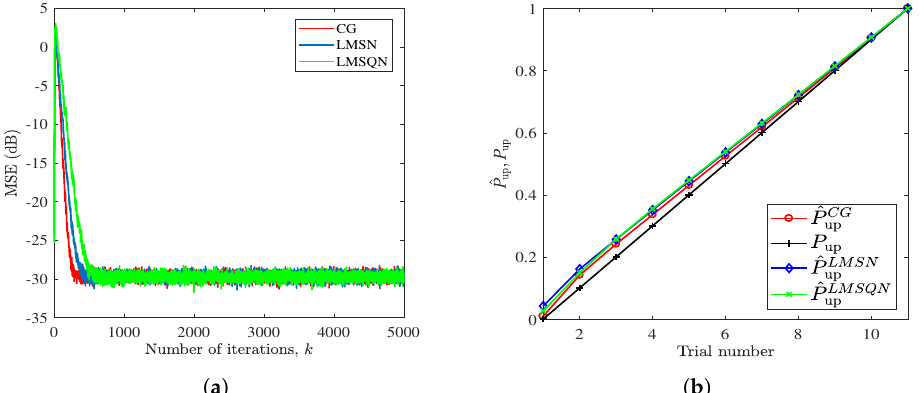
Figure 6. Simulation 3 for first-order AR input signal: ( a ) Learning curves for the data selection and ( b ) Comparison between the desired P up and achieved ˆ P LMSN up , ˆ P LMSQN up and ˆ P CG up by the data-selection